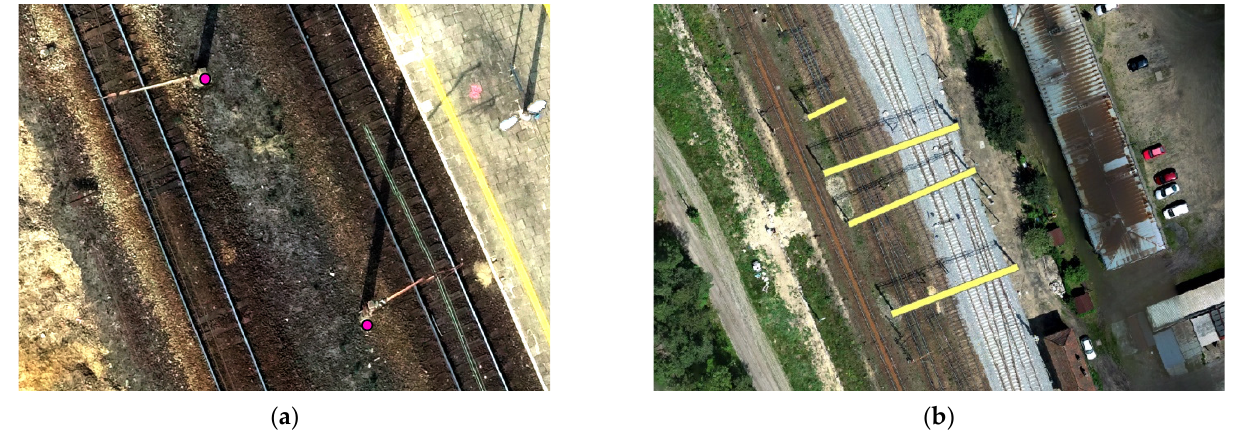
Figure 3. Examples of annotation data for ( a ) traction poles annotated as points and ( b ) gates labelled as polygons based on orthophotomap from UAV images.